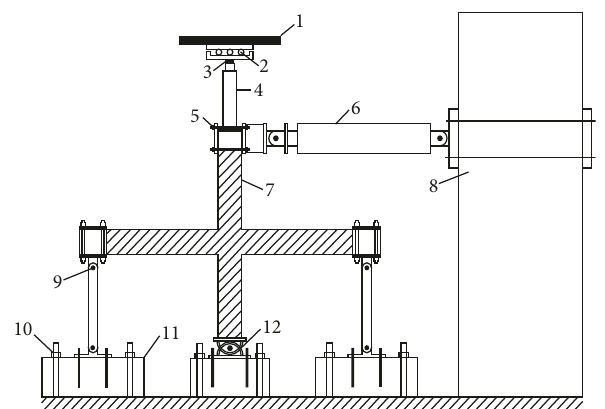
Figure 3: Loading device in the test. (1) Crossbeam, (2) movable hinge support, (3) pressure transducer, (4) lifting jack, (5) holding device, (6) servoactuator, (7) specimen, (8) reaction wall, (9) steel connector with ball hinges, (10) ground anchor screw, (11) steel support, and (12) ball hinge.